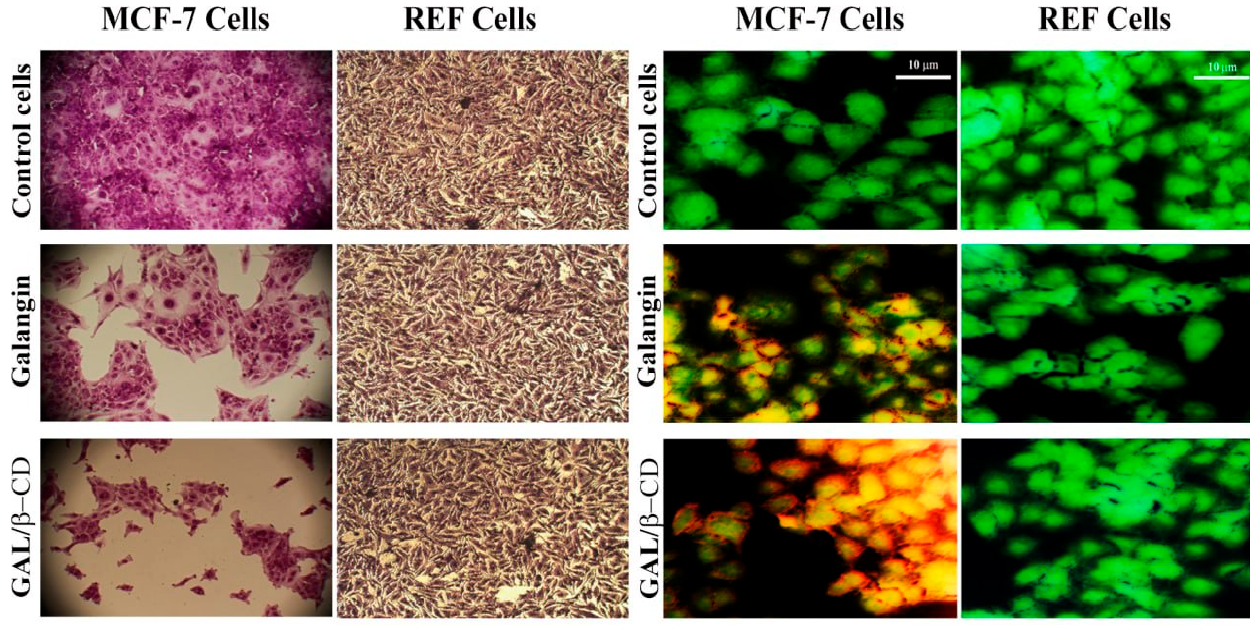
Figure 10. Microscopic images of MCF-7 cell line and REF cell line after treatment with IC 50 of galangin and GAL/ β -CD. ( Left lane) staining with crystal violet dye (magnification power: 40 × ). ( Right lane) acridine orange–ethidium bromide dual staining assay (Scale bar 10 µm).